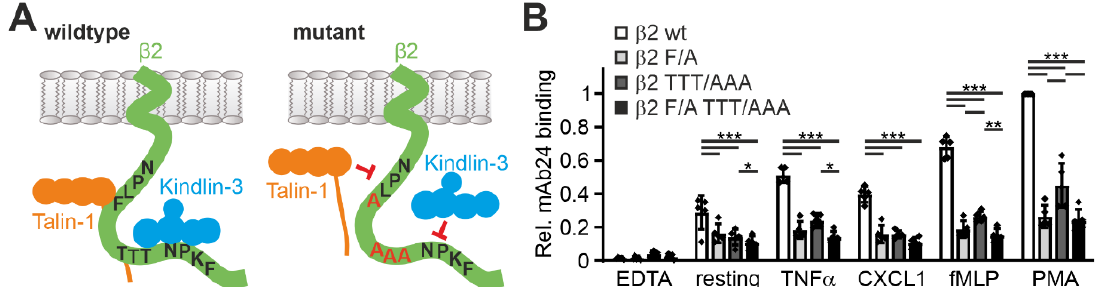
Figure 6. Talin and/or kindlin3 binding- deficient human integrin β2 exhibit impaired integrin activation. ( A ) Scheme of the integrin β2 cytoplasmic domain, which binds talin1 via a membrane proximal NPLF motif and kindlin3 via a membrane-distal NPKF and a TTT motif ( left ). Mutation of these motifs to NPLA and AAA prevent talin1 and kindlin3 binding, respectively ( right ). ( B ) Relative mAb24 binding to neutrophil-like cells derived from Hoxb8 cells expressing human wild-type integrin β2, mutant integrin β2 F/A (F754A), mutant integrin β2 TTT/AAA (T758A, T759A, T760A) , or double- mutant integrin F/A TTT/AAA in response to TNFα, CXCL1, fMLP , and PMA or left untreated. N = 5 experiments indicated as individual data points. All values are given as mean ± SD. * p < 0.05, ** p < 0.01, *** p < 0.001.